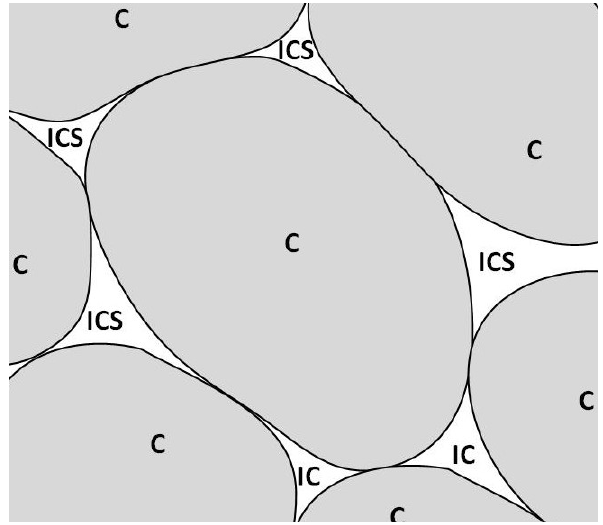
Figure 2. Representation of cells (C) and intercellular spaces (ICS) in vegetal